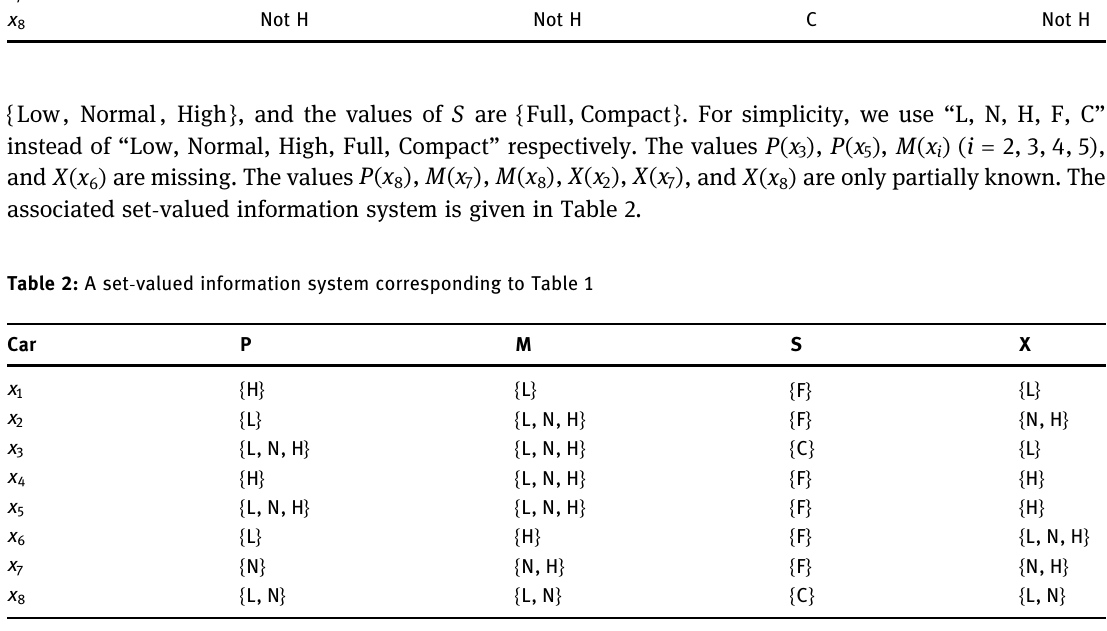
} Full, Compact . For simplicity, we use “ L, N, H, F, C ” instead of “ Low, Normal, High, Full, Compact ” respectively. The values ( ) P x 3 , ( ) P x 5 , , and ( ) X x 6 are missing. The values ( ) 7 , and ( ) X x 8 are only partially known. The associated set - valued information system is given in Table 2.